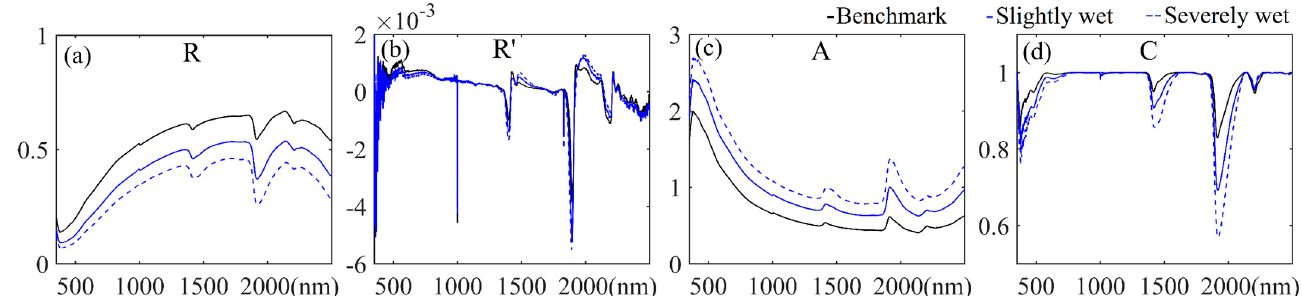
Figure 11. Average spectra of JL samples in soil moisture control experiments: ( a ) spectral reflectance (R); ( b ) the first derivative of the reflectance (R’); ( c ) the spectral absorbance (A); and ( d ) the spectra of continuum removal (C).